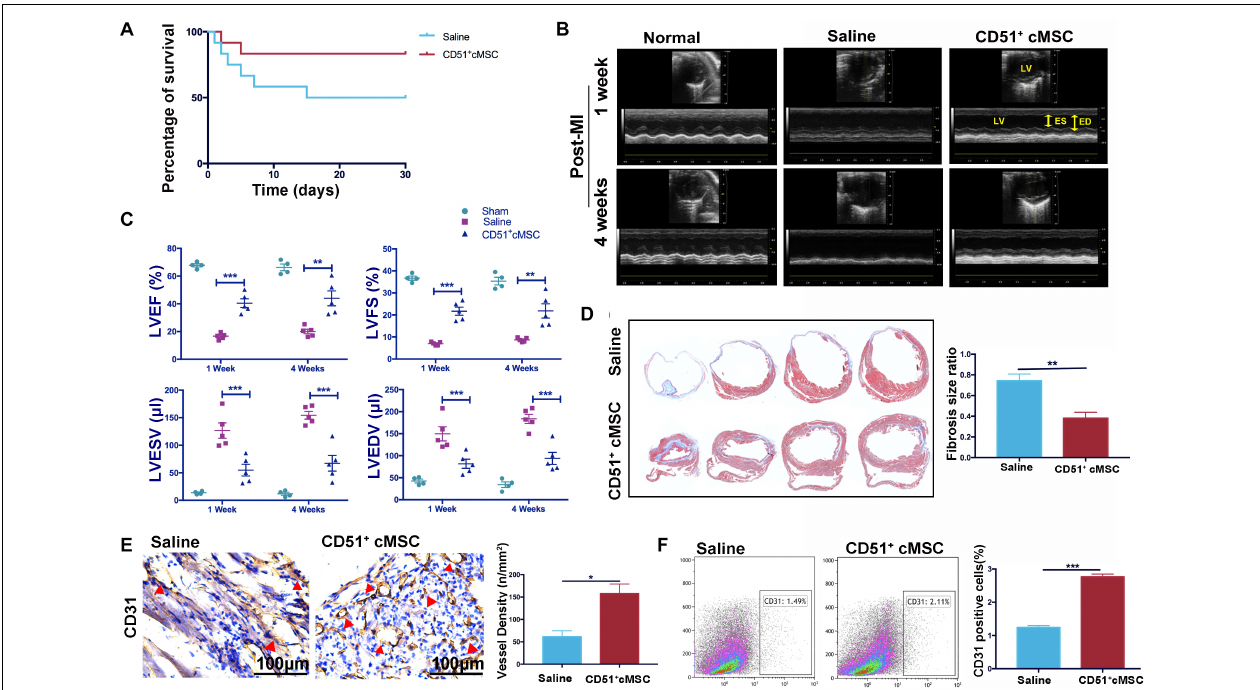
FIGURE 4 | CD51 + cMSC therapy enhanced cardiac repair in mice post AMI. (A) Analysis of the Kaplan–Meier survival curve using the log-rank test, χ 2 = 2.762, P = 0.0965, n = 12 mice per group. (B) Representative M-mode echocardiography images of normal, saline-treated, and CD51 + MSC-treated mice at 1 and 4 weeks post AMI. LV, left ventricle; ES, end systolic; ED, end diastolic. (C) Comparison of echocardiography parameters. LVEF, left ventricular ejection fraction; LVFS, left ventricular fractional shortening; LVESV, left ventricular end systolic volume; LVEDV, left ventricular end diastolic volume; data are presented as mean ± SEM, n = 4. (D) Assessment of myocardial fibrosis using Masson’s trichrome staining at 4 weeks post AMI; fibrosis size ratio was presented as a percentage of fibrosis length of the LV, n = 3. (E) Representative images of immunohistochemical staining with CD31 antibody in the infarcted myocardium at 2 weeks post AMI, the cone indicated the vessels, and values were presented as number of vessels per square meter, n = 3. (F) Analysis of cardiac CD31-positive cells in the infarcted area 2 weeks post AMI by flow cytometry, n = 3. Data in all panels are presented as mean ± SEM, * P < 0.05, ** P < 0.01, and *** P < 0.001.